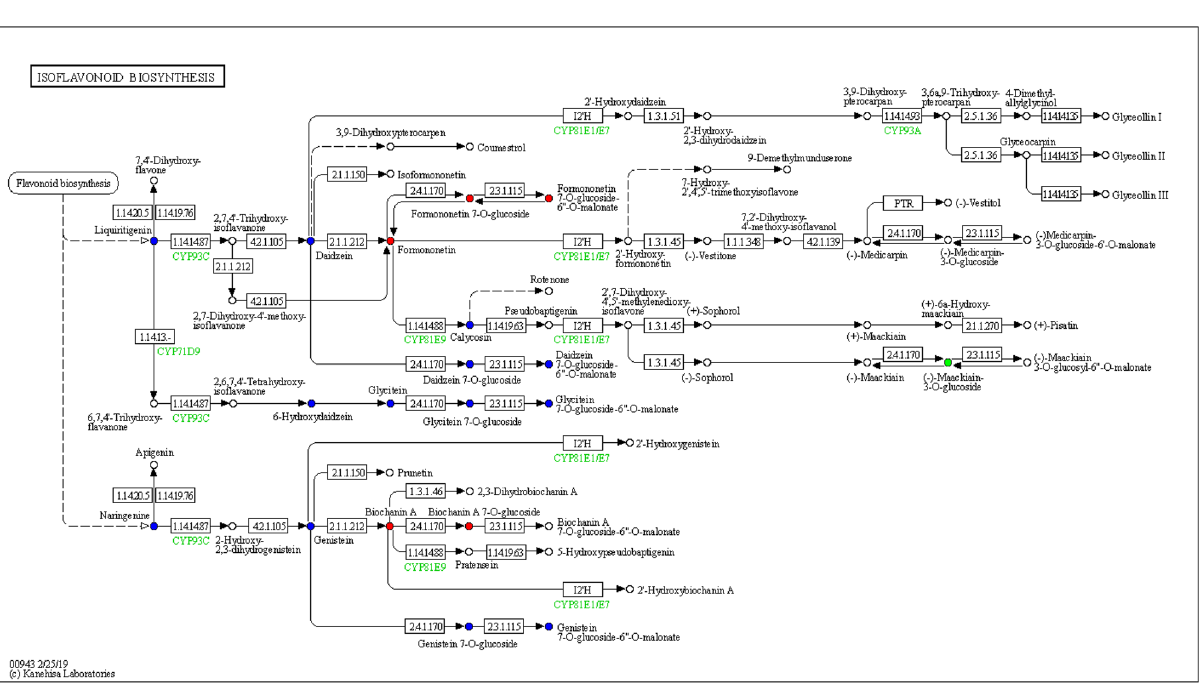
Figure 5. Differential metabolite KEGG pathway diagram. Note: Red indicates that the metabolite content is significantly up-regulated in the experimental group, and blue indicates that the metabolite is detected but not significantly changed. Green indicates that the metabolite content is significantly down-regulated in the experimental